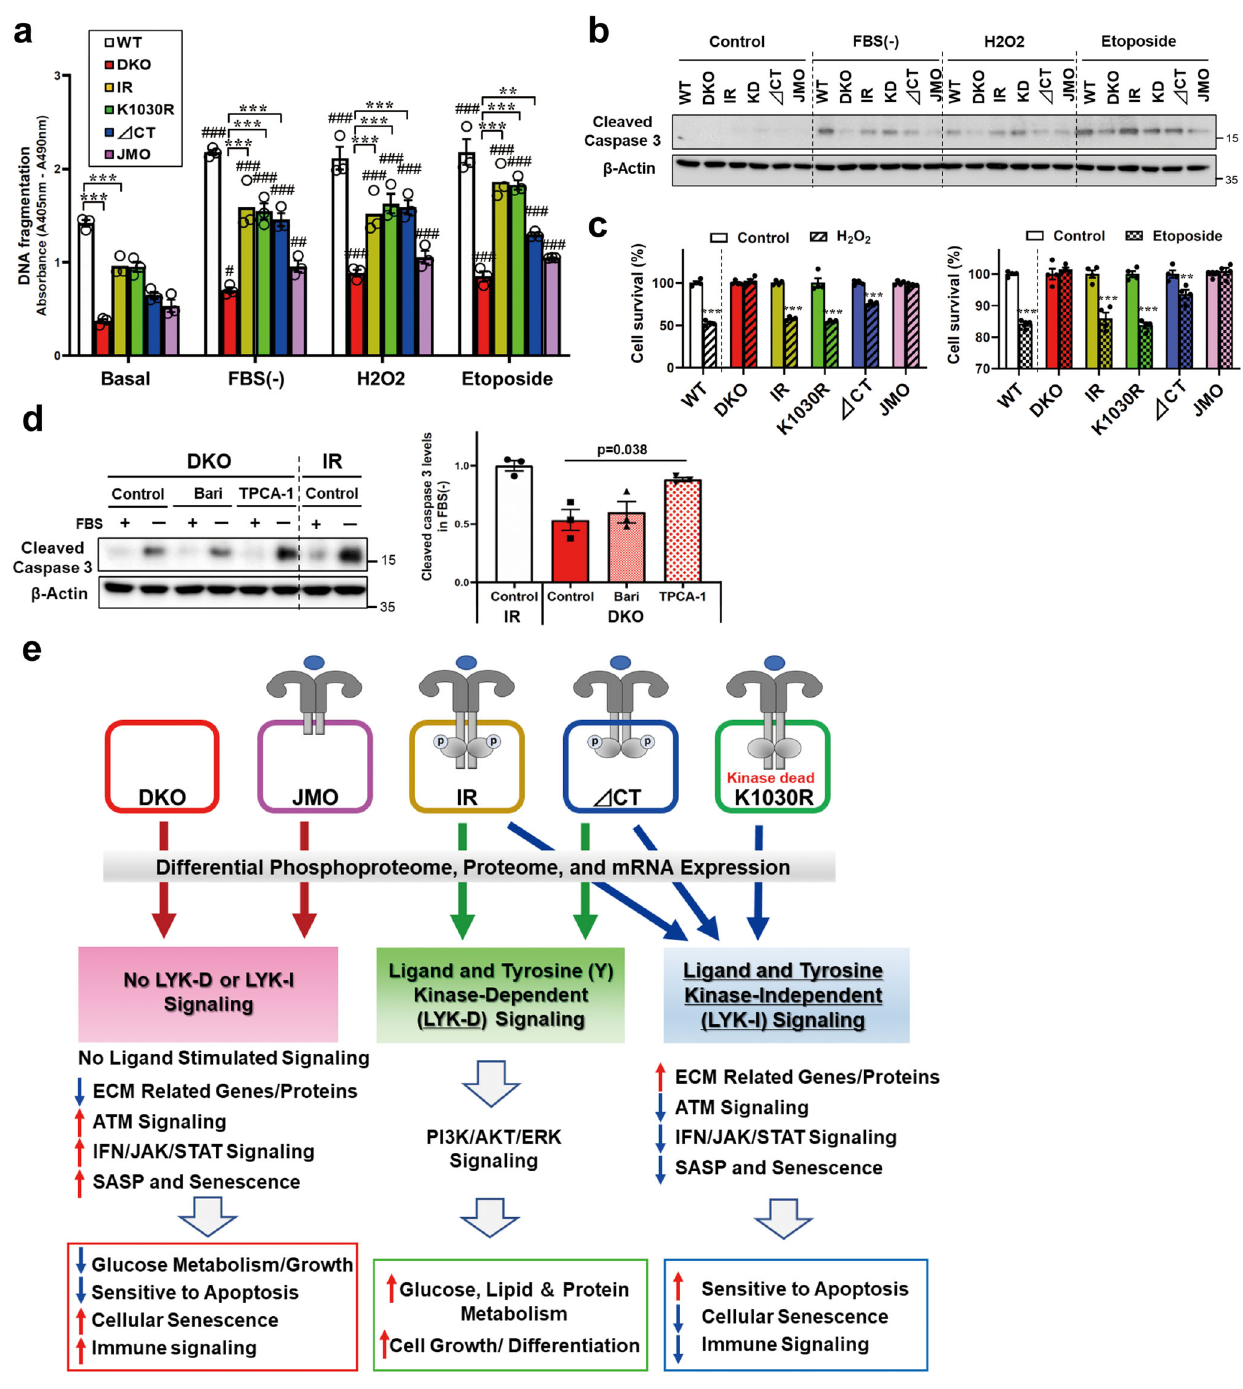
Fig. 8 | LYK-I signaling contributes to cellular sensitivity to apoptosis. a , b Changes in DNA fragmentation ( a ) and immunoblotting of cleaved caspase 3 ( b ) in WT,DKO, IR,K1030R, Δ CT,and JMOcells following serum starvation for 6h, 500 µ M H 2 O 2 for 24h or 25 µ M etoposide for 24h ( n =3). Data are means±SEM. ** P <0.01, *** P <0.001 vs. DKO, # P <0.05, ## P <0.01, ### P <0.001 vs. basal, two-way ANOVA. c Cell viability in WT, DKO, IR, K1030R, Δ CT, and JMO cells treated with 2mMH 2 O 2 or50 µ Metoposidefor24husinganAlamarBlueassay( n =4).Dataare means±SEM. ** P =0.002, *** P <0.0001, control vs. treatment. d Immunoblotting of cleaved caspase 3 levels in lysate from DKO and IR cells with or without 6h FBS starvation. Before FBS starvation, cells were treated with baricitinib (JAK-1/2 inhi- bitor) or TPCA-1 (IKK inhibitor) for 48h ( n =3). Data are means±SEM. The level